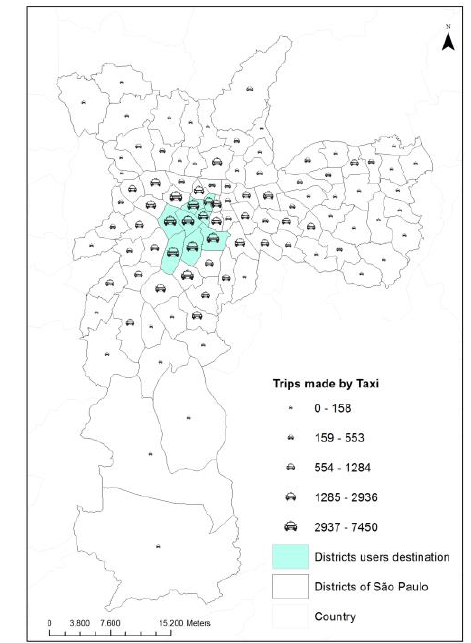
Figure 6. Number of trips: taxi (Source: